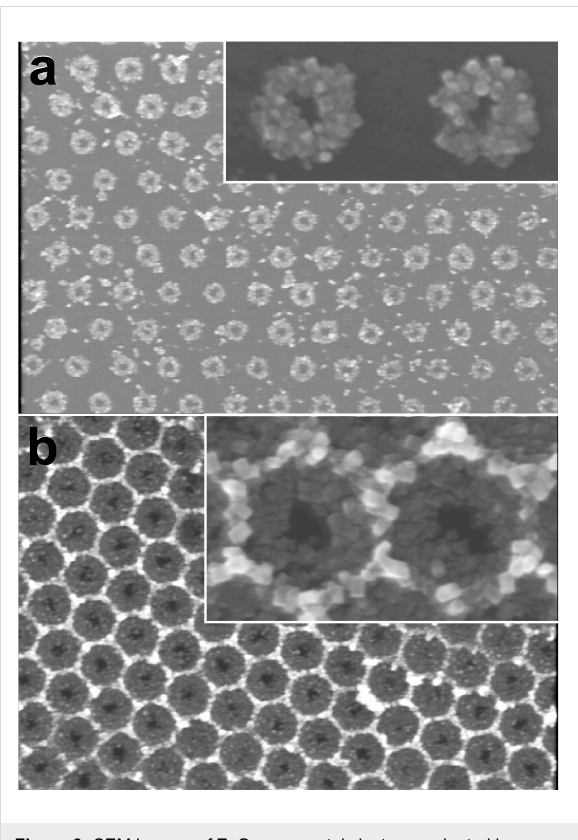
Figure 3: SEM images of ZnO nanocrystal clusters nucleated in shapes of an island array (a) and a honeycomb (b) on TiO 2 seed patterns comparable to those in Figure 2a and Figure 2e, respectively. The insets show the magnified portions of each image.